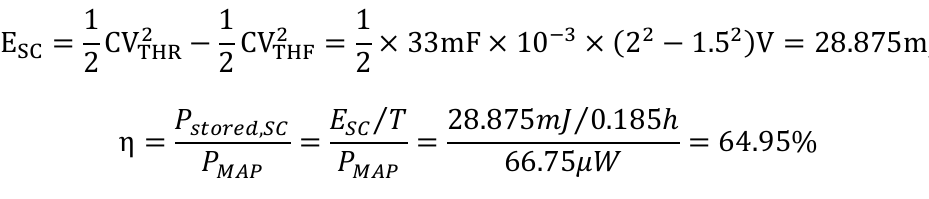
Figure 13. The voltage across the super-capacitor and wireless sensor